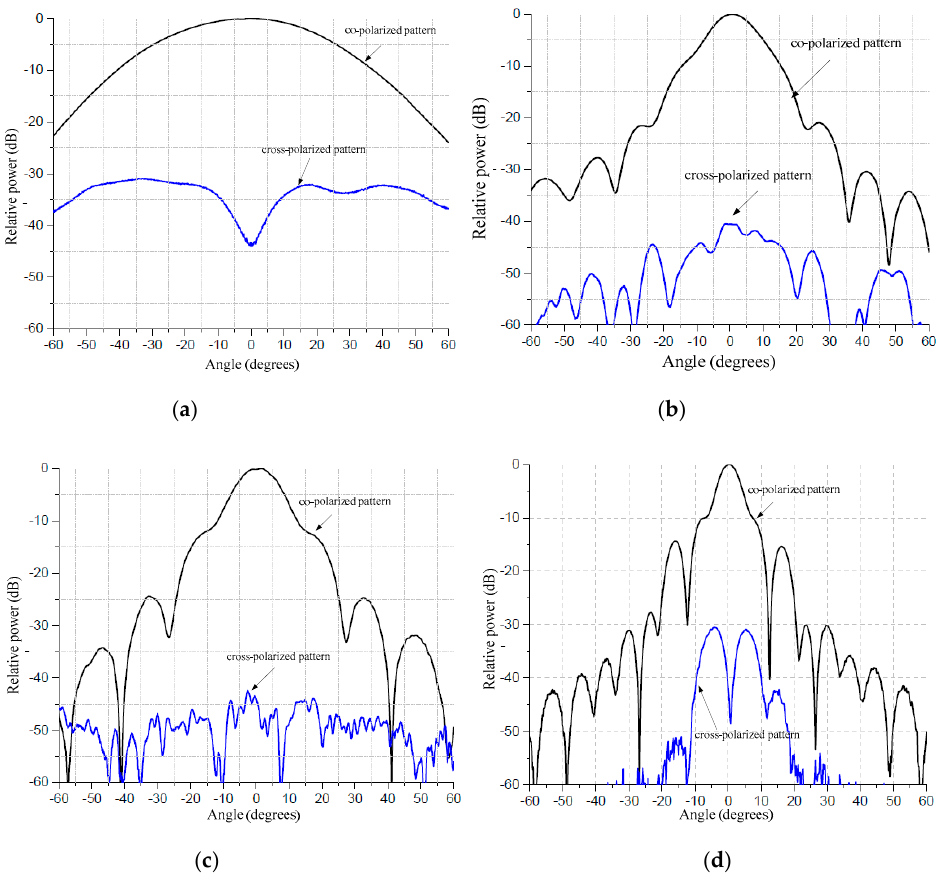
Figure 8. Examples of measured patterns: ( a ) L-band; ( b ) C-band; ( c ) X-band; ( d ) Ka-band.